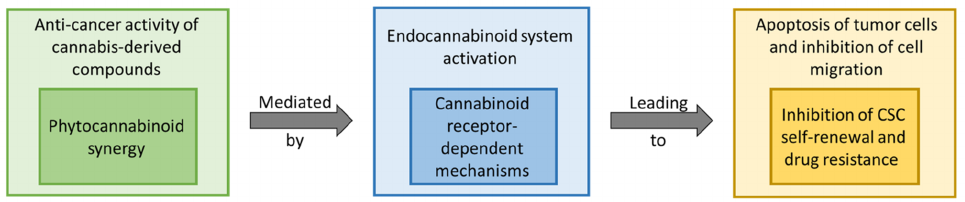
Figure 2. Conceptual perspective of the anti-cancer activity of phytocannabinoids. Cannabis compounds and phytocannabinoids, in particular, by activating cannabinoid receptor-dependent mechanisms, may interact synergistically in some of the cases and target malignant cells by inducing, e.g., cell apoptosis and inhibition of cancer cell migration. Moreover, phytocannabinoids may target CSCs, in some cases leading to an improved outcome, e.g., by inhibiting the characteristic self-renewal and drug resistance of CSCs.